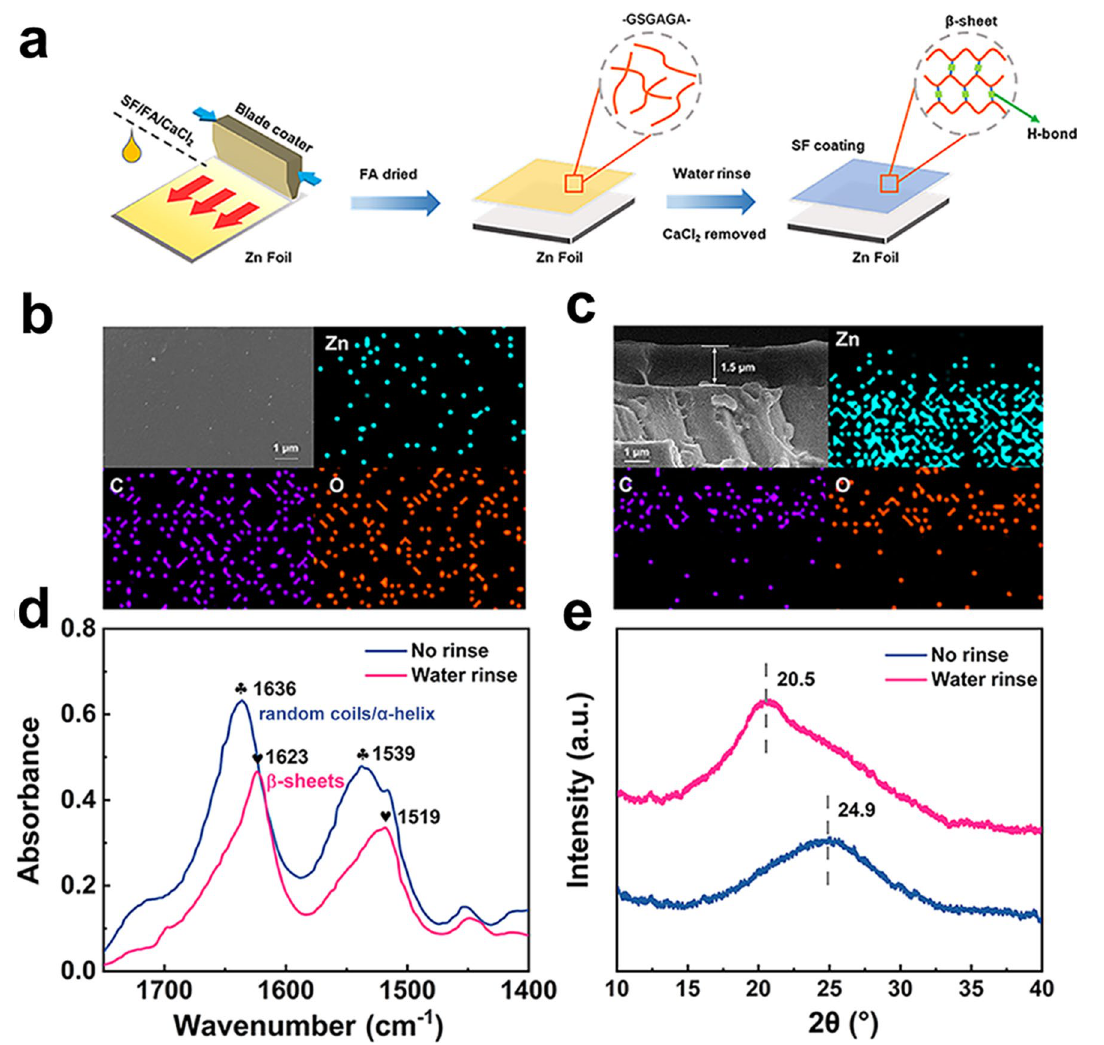
Fig. 1 Preparation and characterization of Zn‑SF anode. a Preparation of Zn anode with SF coating. b Surface and c cross section SEM images of Zn‑SF anode after a water rinse. d FT‑IR spectra and e XRD patterns of SF coating before/after water